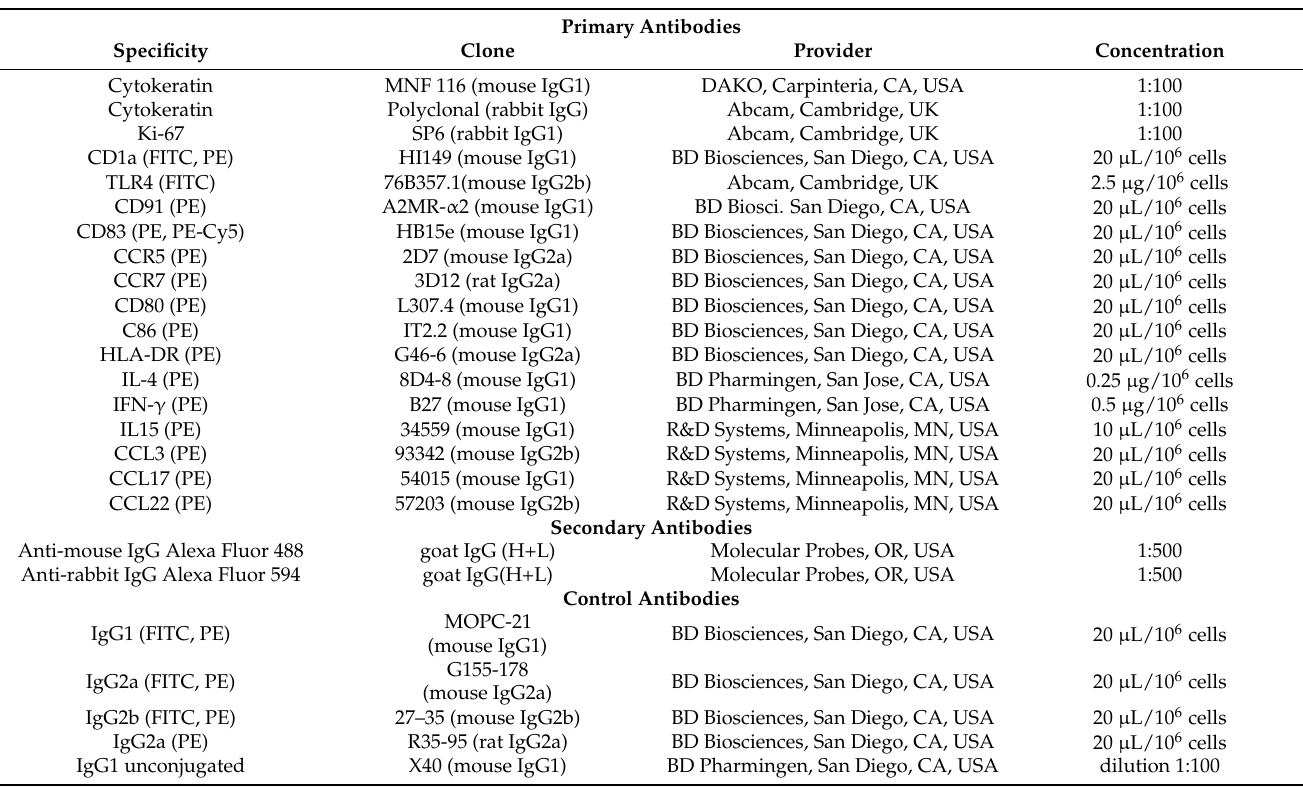
Table 1. Specification of antibodies